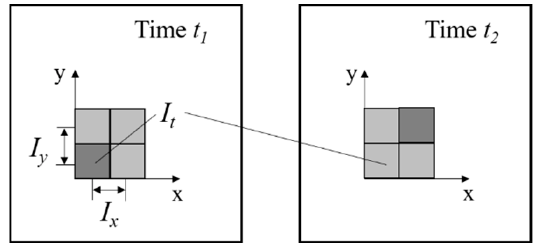
Figure 2. The principle of optical flow methods.